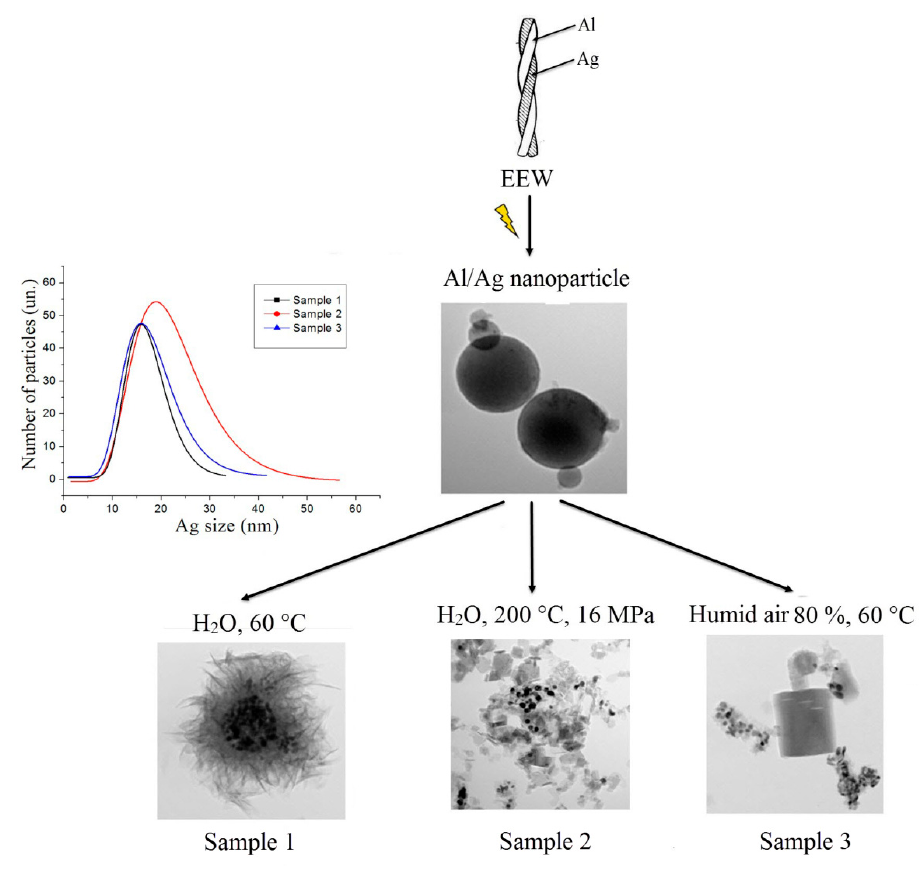
Figure 9. Scheme of different morphology nanostructure formations during water oxidation of Al/Ag nanoparticles under different conditions.